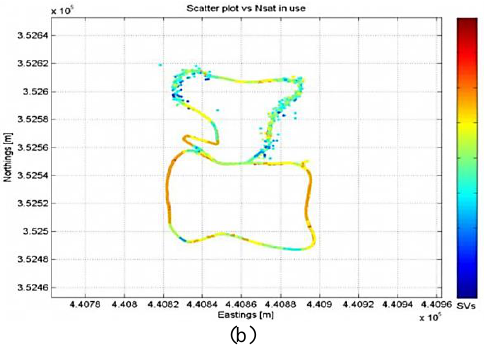
Figure 6. GS10 Mobile Kinematic Results: (a) HDOP vs. 2D; (b) No. SV vs. 2D